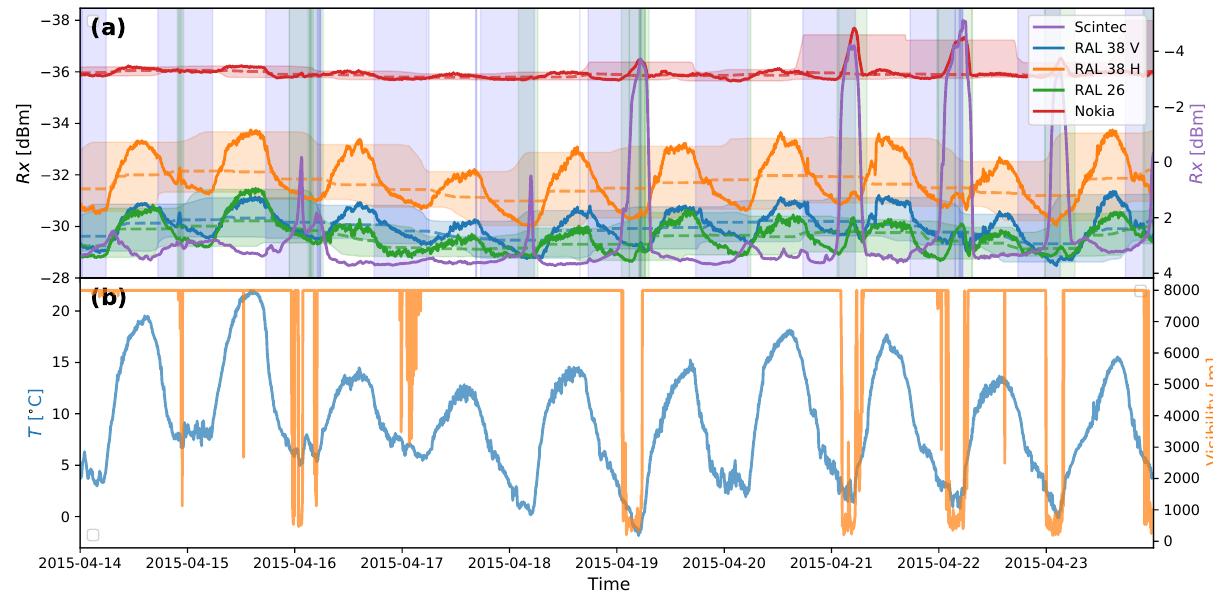
Figure 10. Time series of the period between 14 April 2015 and 24 April 2015. (a) Received power levels (solid lines) and reference levels (median over dry periods in a 24h moving window: dashed lines). Periods with a negative net radiation flux at the surface are indicated with blue shading. Periods with a relative humidity > 90% are indicated with green shading. (b) Several atmospheric variables measured at the “Veenkampen” meteorological station: visibility and ambient air temperature at 2m indicated with orange and blue lines, respectively.